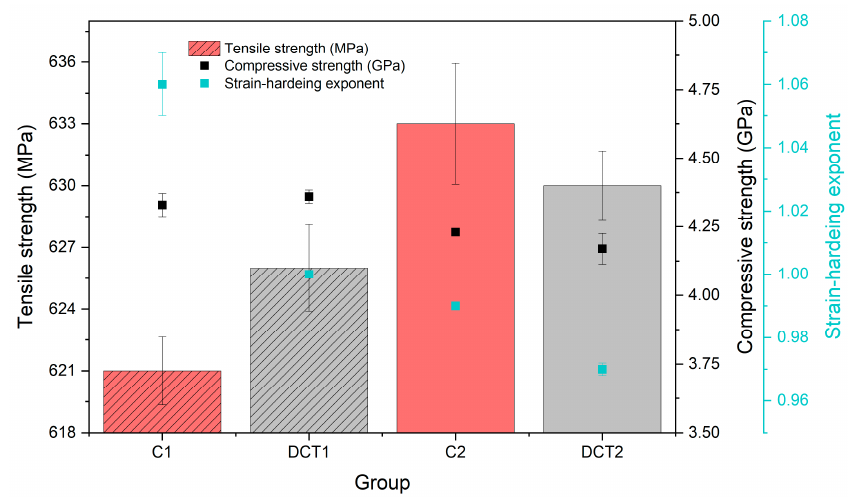
Figure 5. Measured tensile (in MPa), compressive strength (in GPa), and strain-hardening exponent for all four subgroups. C1 and C2 are conventionally heat-treated groups, whereas DCT1 and DCT2 are deep cryogenically heat-treated.